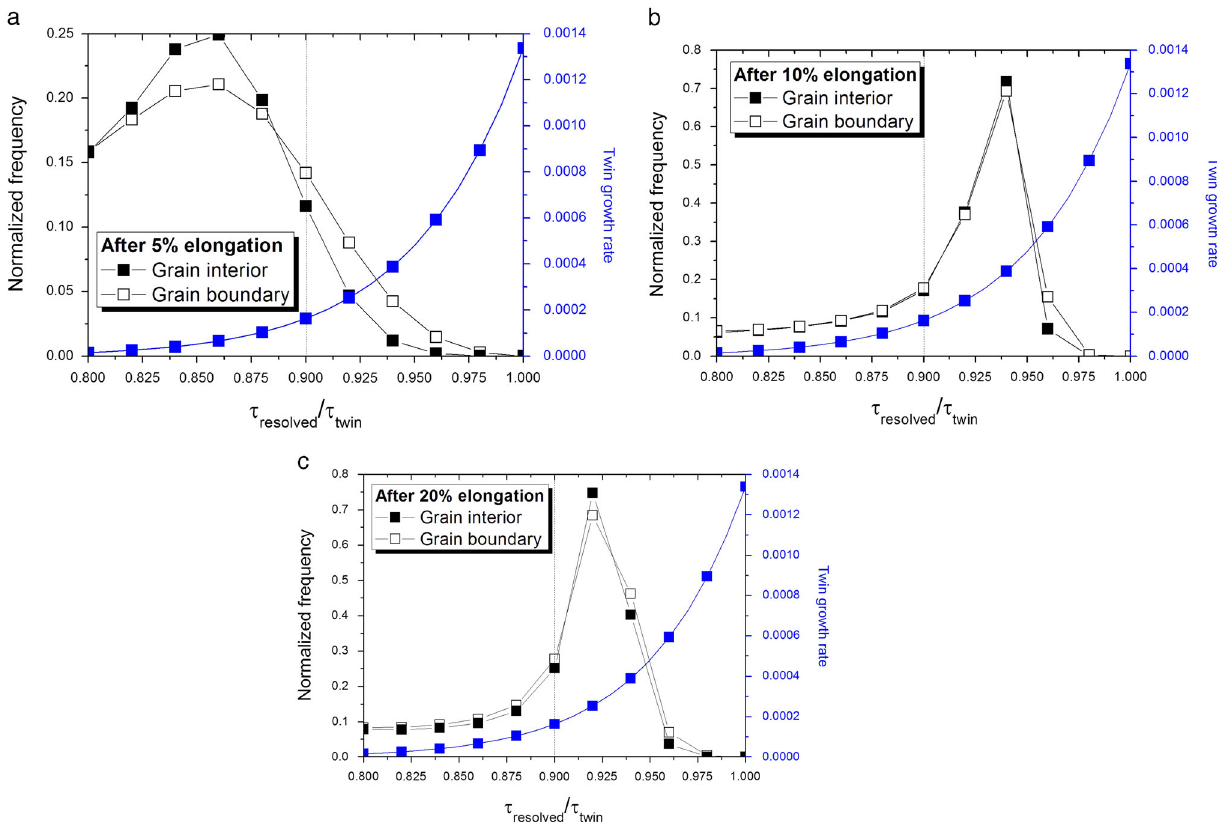
Fig. 4 Distribution of shear stress normalized by twin resistance of grain interior and grain boundary regions after a 5%, b 10%, and c 20% elongations, respectively. The curve colored in blue represents the twin growth rate against normalized shear stress value and the dotted line represents the point at which twin growth rate is more than 10% of the maximum growth rate